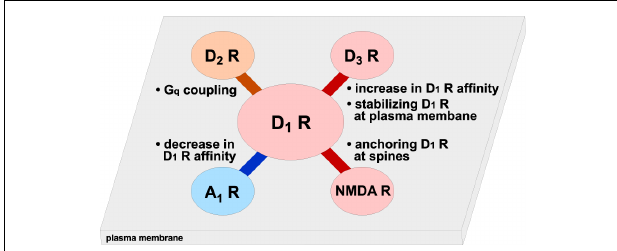
FIGURE 2 | D 1 receptors form hetero-oligomers with other receptors. Formation of hetero-oligomers with dopamine D 1 receptors and other receptors such as D 2 , D 3 , A 1 , and NMDA receptors is shown. Biding of these receptors induces the changes in D 1 receptor function and/or